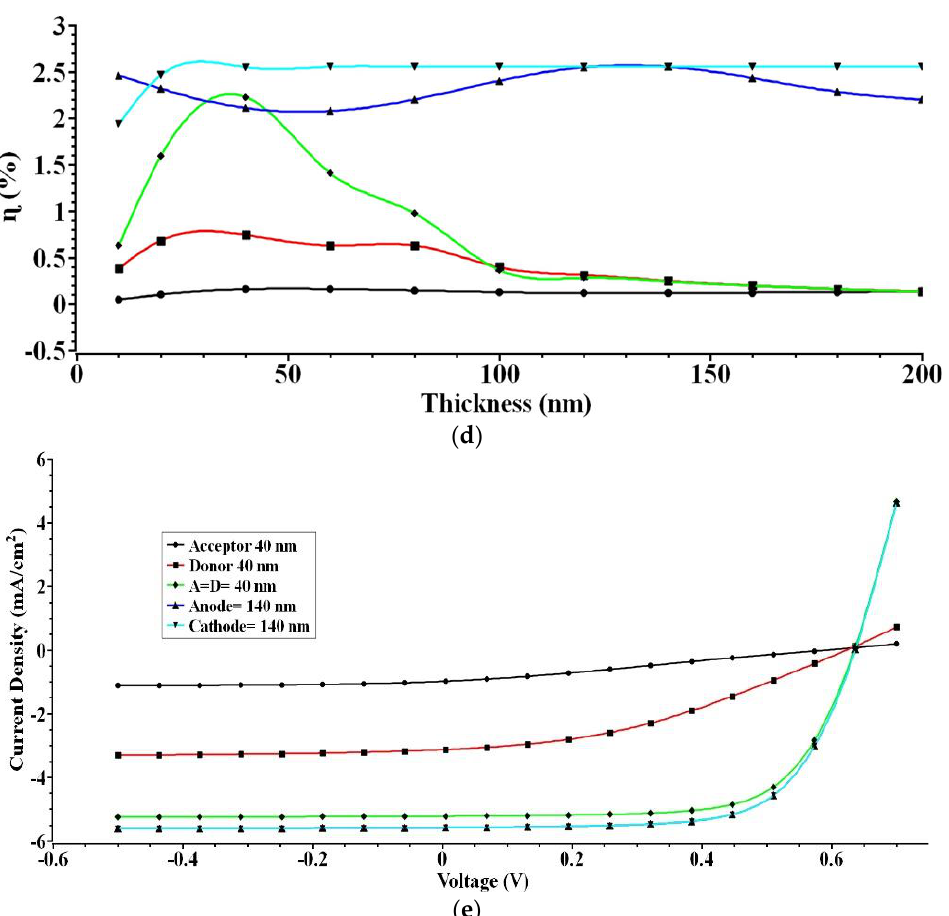
Figure 3. ( a ) J sc ( b ) Voc ( c ) FF ( d ) ɳ ( e ) JV curve. Illustrates the output extracted for various layer thicknesses.